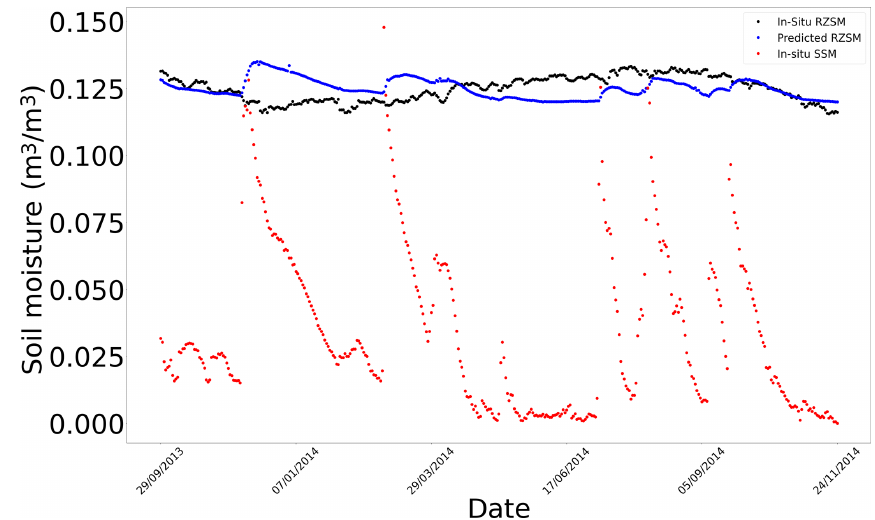
Figure F4. In situ SSM, in situ RZSM, and predicted RZSM time series at the stations in the Kairouan Plain (Tunisia) with model ANN_SSM_NDVI_EVAP-EFF-B60_EXP-FILT-T5 (see Appendix G for a larger figure format).